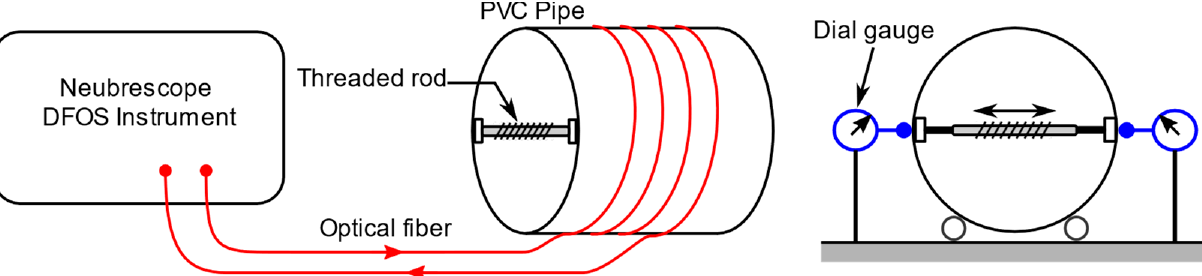
Figure 6. Schematics of experiment setup.